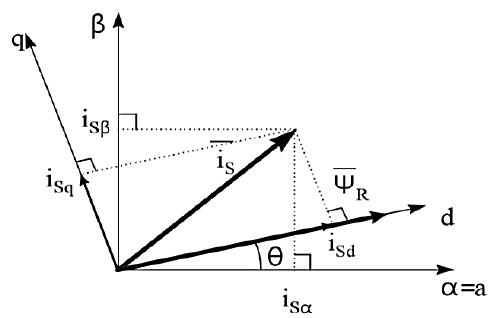
Figure 11. Stator-current vector and its components in the ( α, β ) and ( d, q )